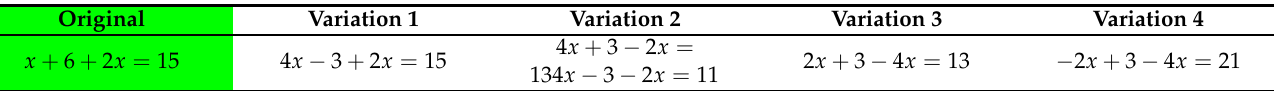
Table 17. Examples of non-simplified equations and variations based on ax + b + cx = d [14]. Original Variation 1 Variation 2 Variation 3 Variation 4 x + 6 + 2 x = 15 4 x − 3 + 2 x =